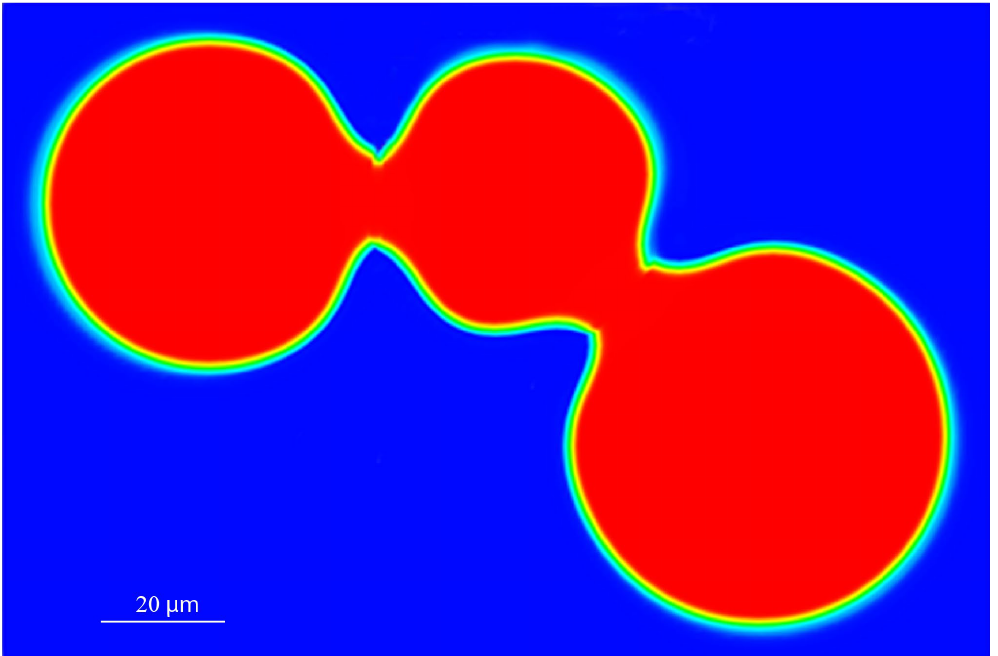
Figure 8. Result of the simulation conducted considering the RBM parameters obtained from SET C and SET D.